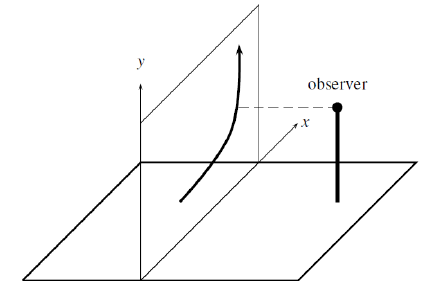
Figure 2. Observer position.